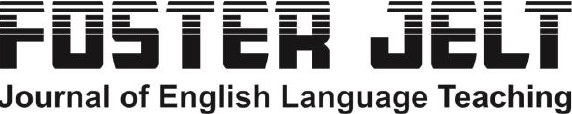
Table 2: The Result of the X AKL Students' daily scores in speaking X AKL X PKM